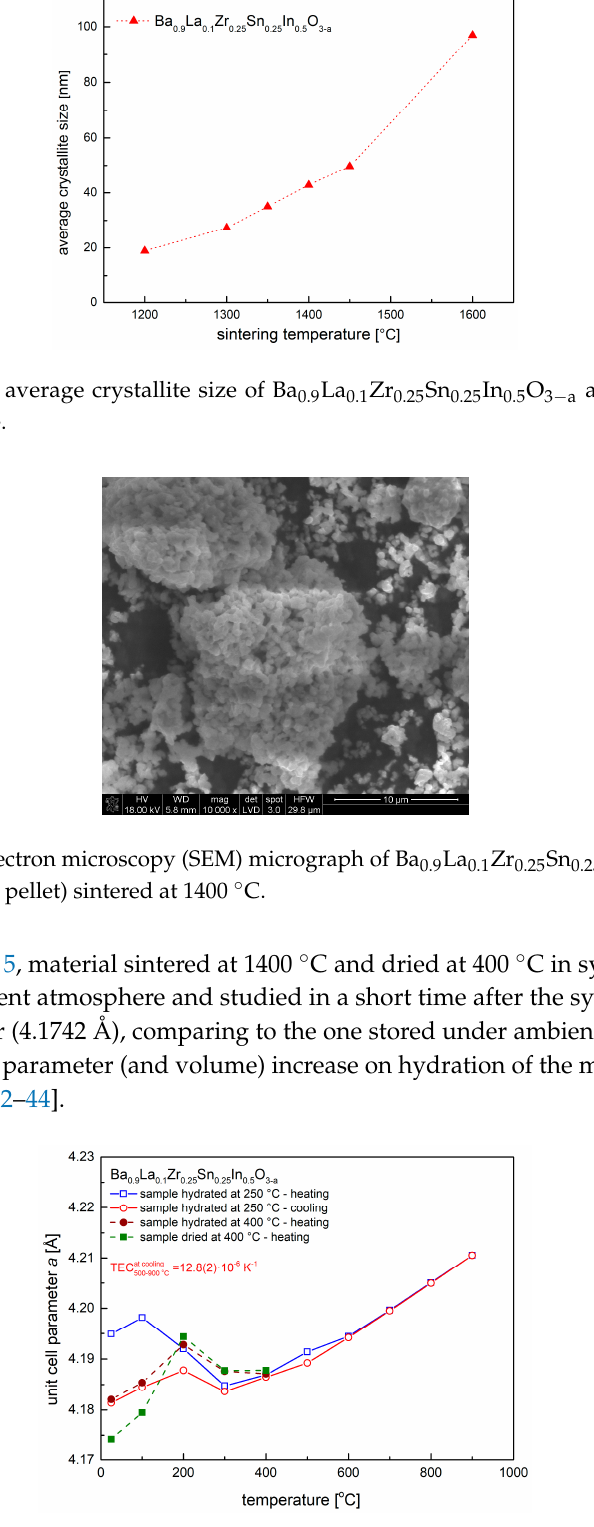
Figure 5. Unit cell parameter dependence on temperature, as calculated from high-temperature XRD data, recorded in synthetic air for samples, which were previously hydrated at 250 °C and 400 °C, as well as dried at 400 °C.